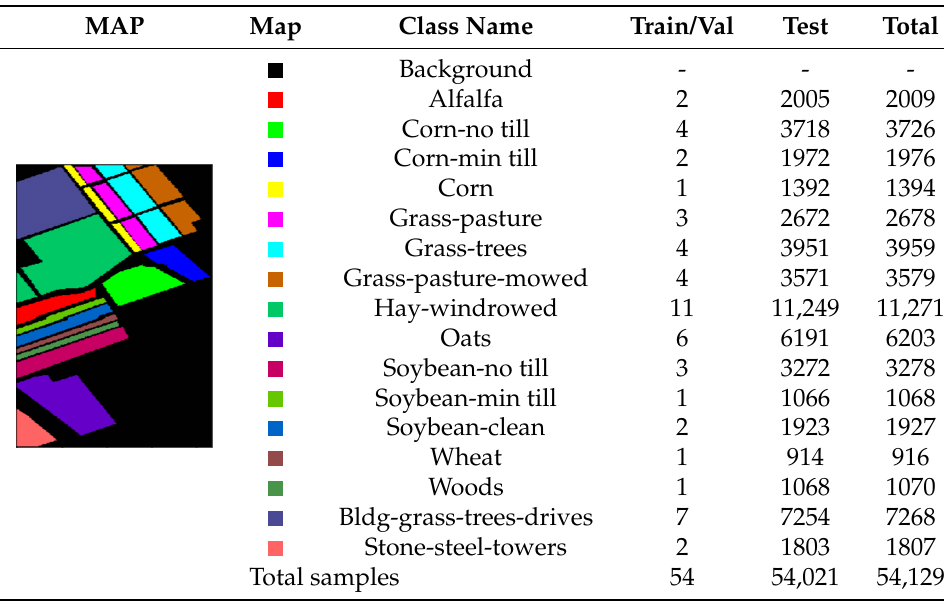
Table 4. Sample labels and sample size for the Salinas Scene